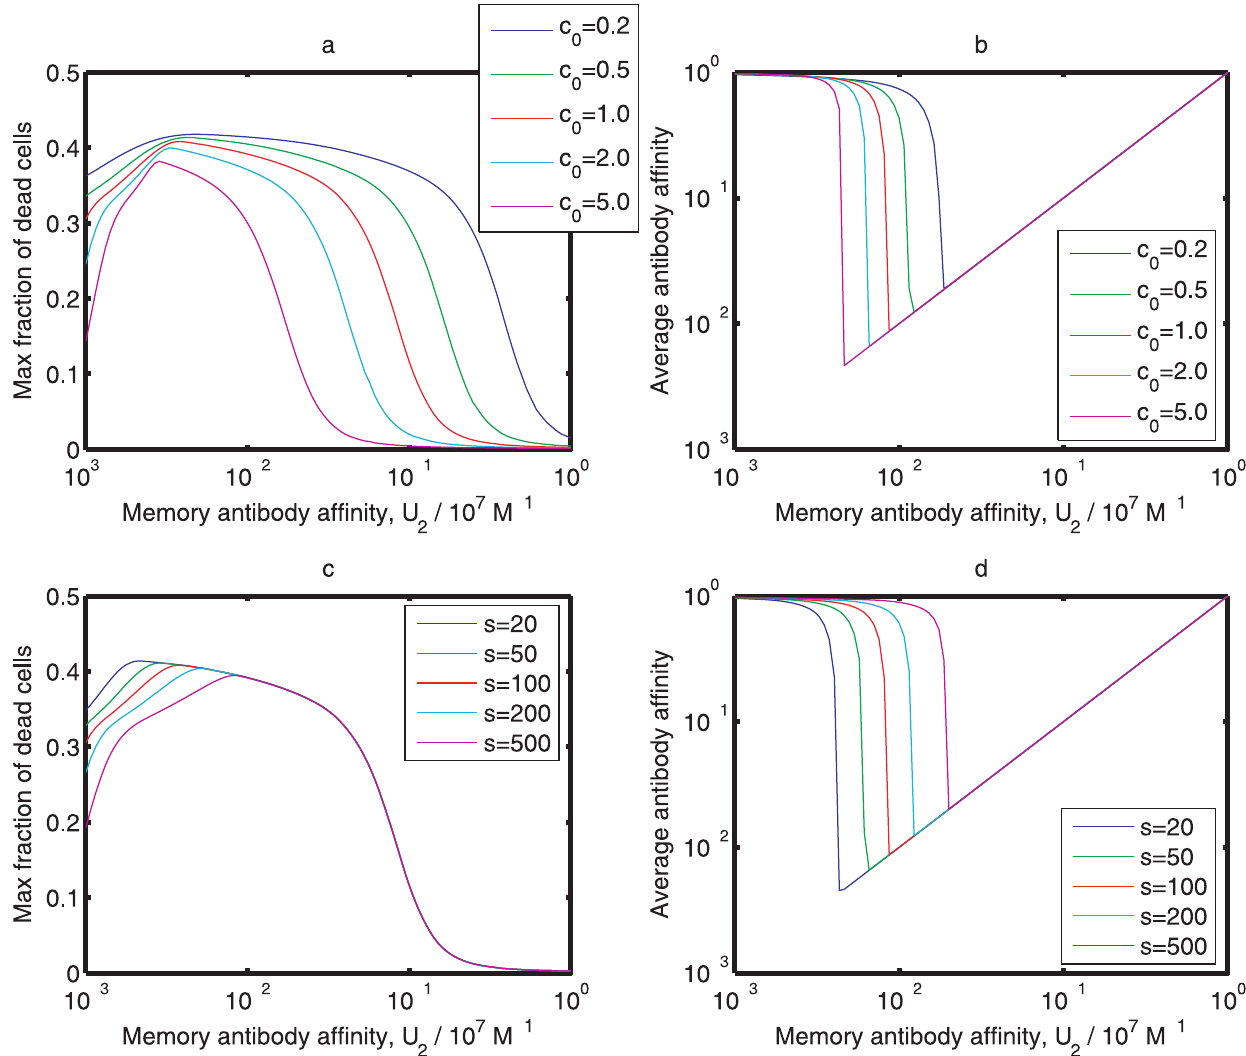
Figure 6. Sensitivity analysis of parameters c 0 and s . (a) and (b) The maximum percentages of dead cells and the average antibody affinities at different values of c 0 . (c) and (d) The maximum percentages of dead cells and the average antibody affinities at different values of s . Initial conditions and parameters other than c 0 and s are the same as those in Figure 3.